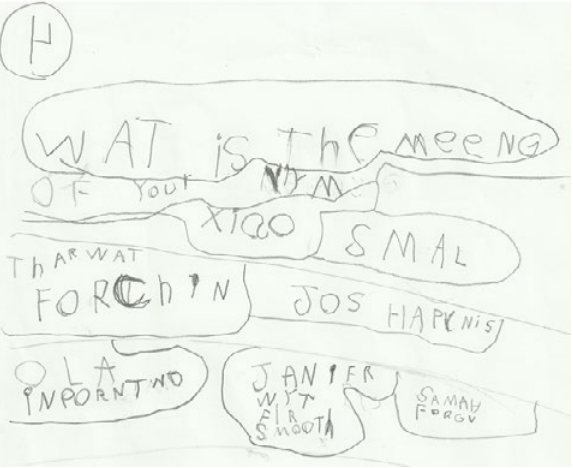
Figure 7: A five-year-old’s survey recording sheet asking staff members: “What is the meaning of your